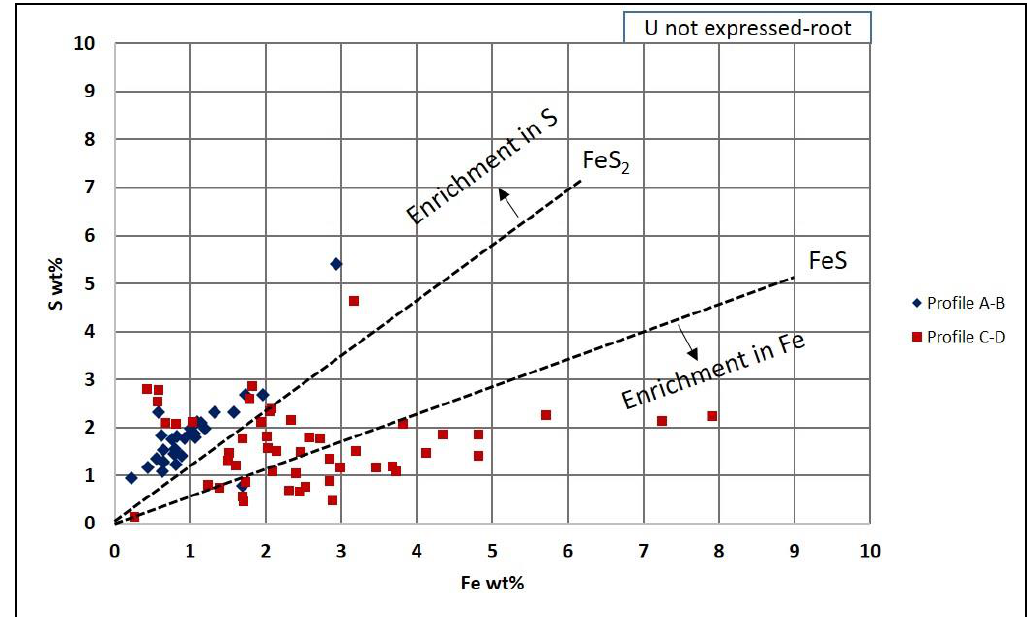
Figure 9. S-Fe wt % composition plot derived from the EPMA measurements along profiles A-B and C-D presented in Figure 8. Profile A-B was performed on the internal part of the root structure, whereas C-D was performed in the external part. For the internal part, the data points (in blue) distribute close to the pyrite line, with a slight relative S enrichment. For the external part, most data points in red indicate significant Fe enrichment at constant S concentration.